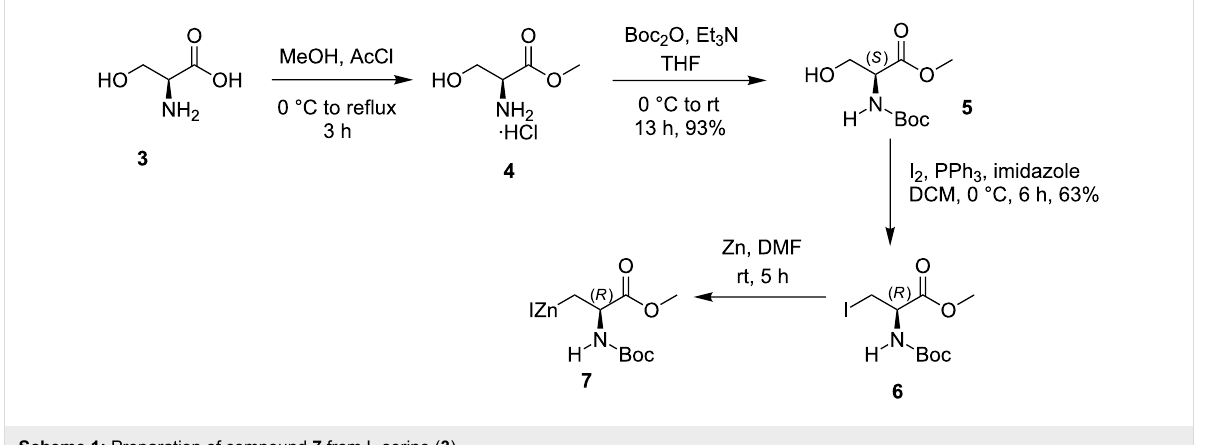
Scheme 1: Preparation of compound 7 from L-serine ( 3